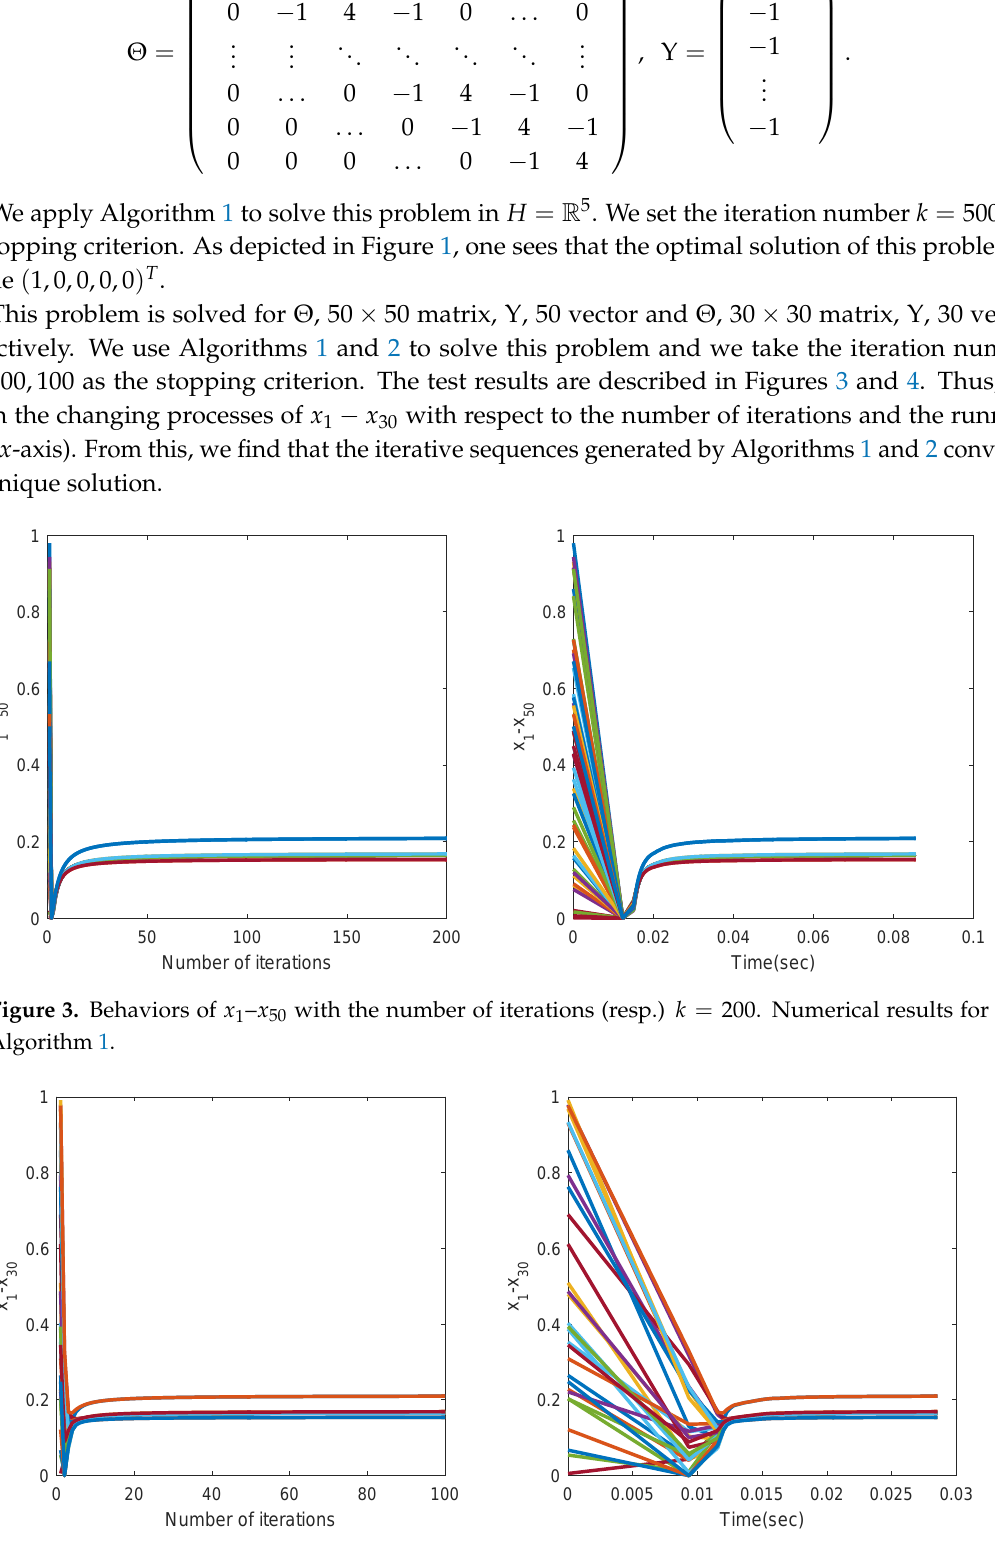
Figure 4. Behaviors of x 1 – x 30 with the number of iterations (resp.) k = 100. Numerical results for Algorithm